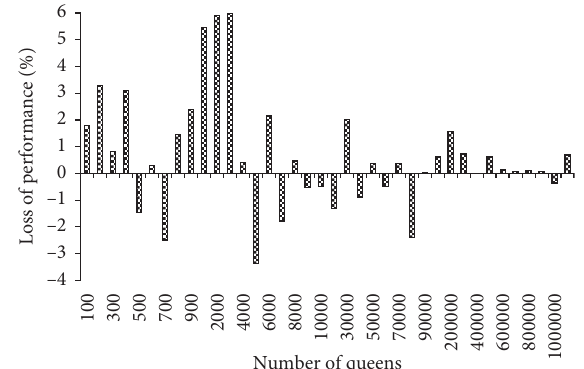
Figure 6: Performance loss of coarse-grained GPU scheme in the worst case.